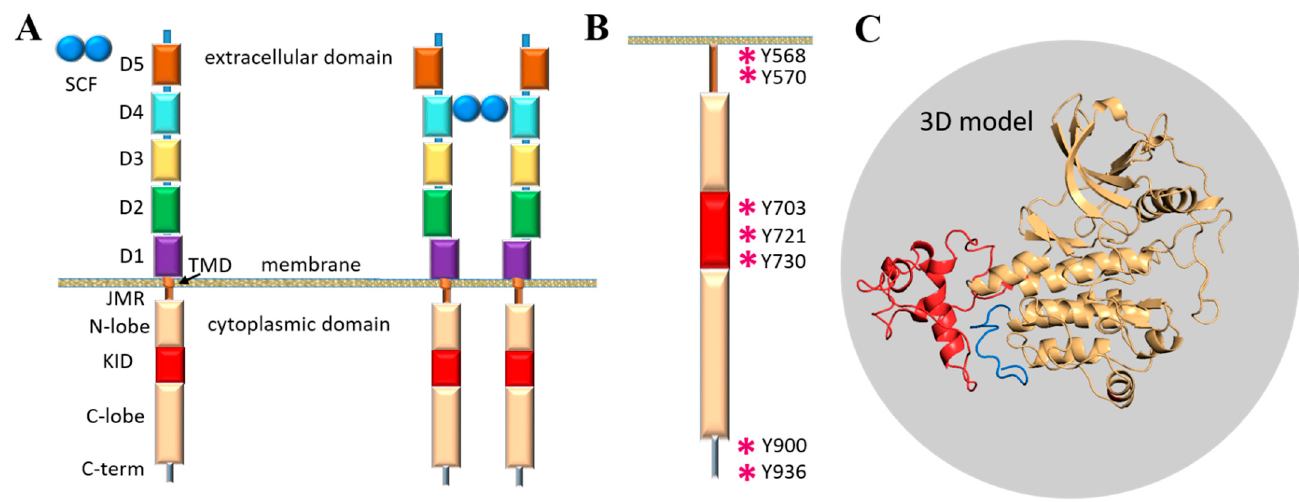
Figure 1. The modular structure of RTKs illustrated with KIT, a member of the RTK family III. ( A ) Structural composition of KIT: an extracellular domain (ECD) with five Ig-like regions (D1–D5), a transmembrane domain (TMD) and a cytoplasmic domain (CD) comprising a juxtamembrane region (JMR), an ATP-binding region (N-lobe), the phosphotransferase domain (C-lobe) with a kinase insert domain (KID) and a C-terminal. The stem cell factor (SCF) extracellular binding induces dimerisation and activation of KIT. ( B ) The tyrosine residues (Y, showed by asterisk) of JMR, KID and C-terminal identified as the phosphorylation sites involved in the recognition of cellular partners. ( C ) 3D structural model of the KIT CD with KID (red) and C-term (blue) [11].